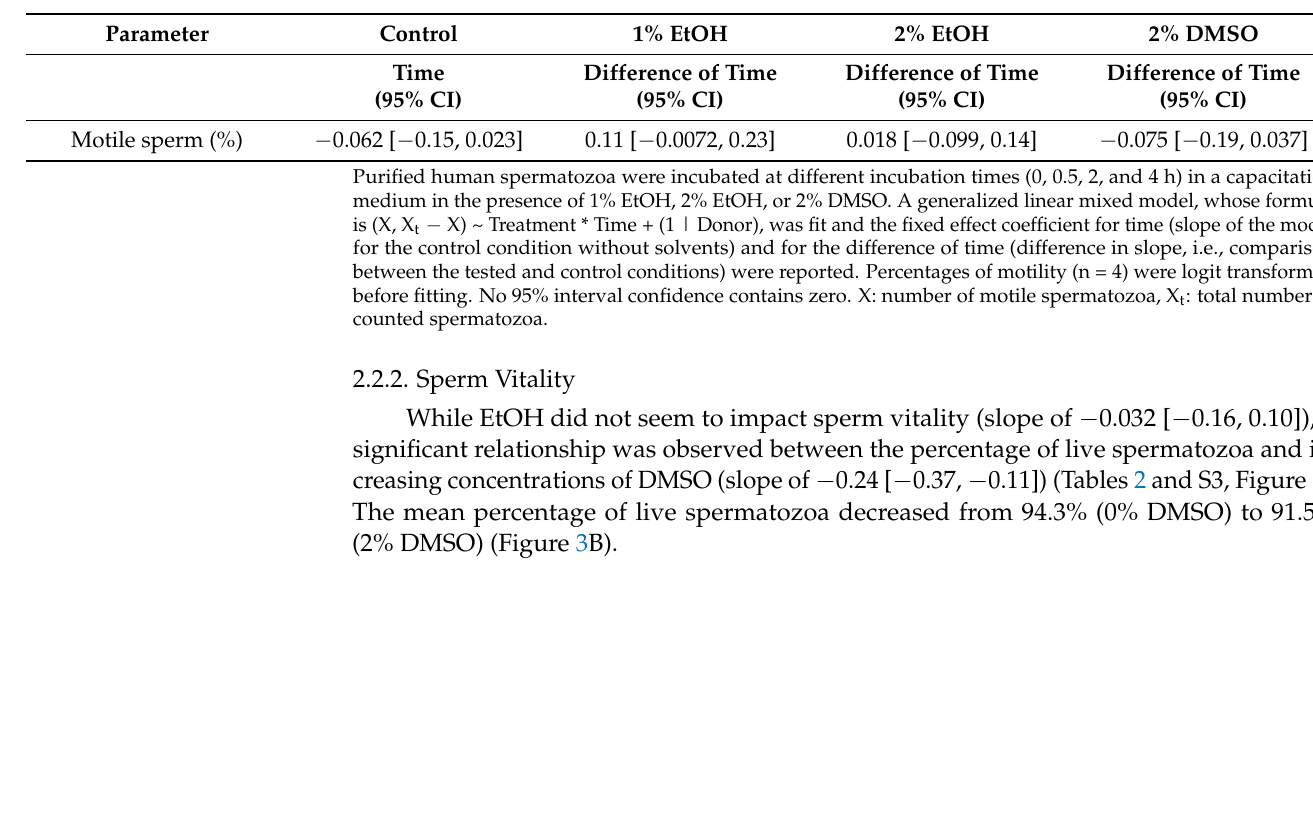
Figure 2. Influence of 1% and 2% ethanol (EtOH) as well as 2% dimethyl sulfoxide (DMSO) on total ( A ) and progressive ( B ) sperm motilities at various incubation times. Values for each replicate (n = 4) are highlighted by a small dot whose color refers to the tested condition (i.e., 1 or 2% EtOH or 2% DMSO). Large dots represent mean values for each tested incubation time within the same condition. Colored lines represent the mean model fit across all donors within the same condition. (Table 3 and Table S4). Table 3. Influence of 1% and 2% ethanol (EtOH) and 2% dimethyl sulfoxide (DMSO) over time on sperm total motility, shown through fitting linear mixed models. The fixed effect coefficient for time (for the control condition) and for the difference of time (comparison between the tested and control conditions) are shown with 95% confidence